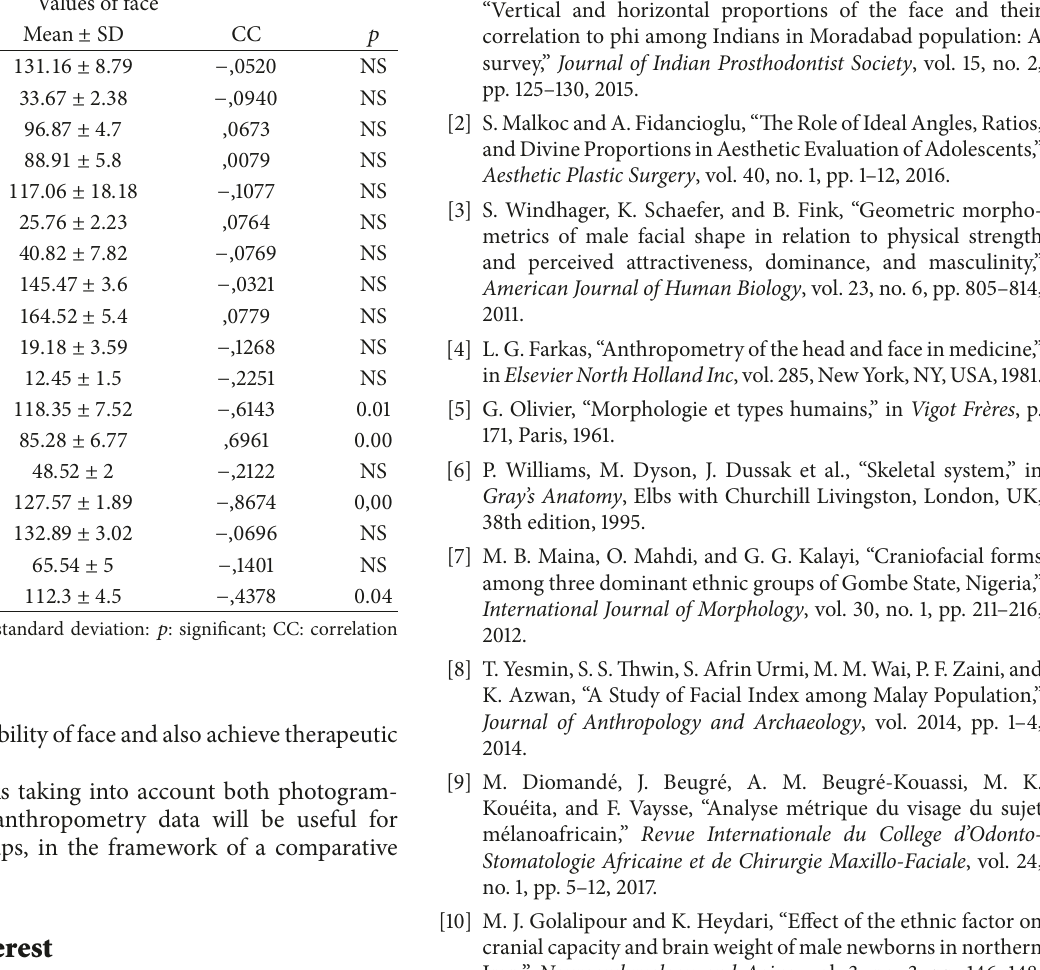
“Vertical and horizontal proportions of the face and